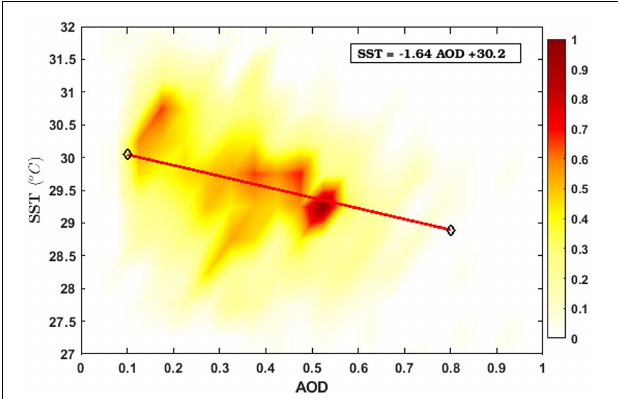
FIGURE 3 | The scatter plot showing the relationship between SST and AOD for April 2003–2019. The color bar represents the number density at each pixel normalized by the maximum over the whole SST-AOD